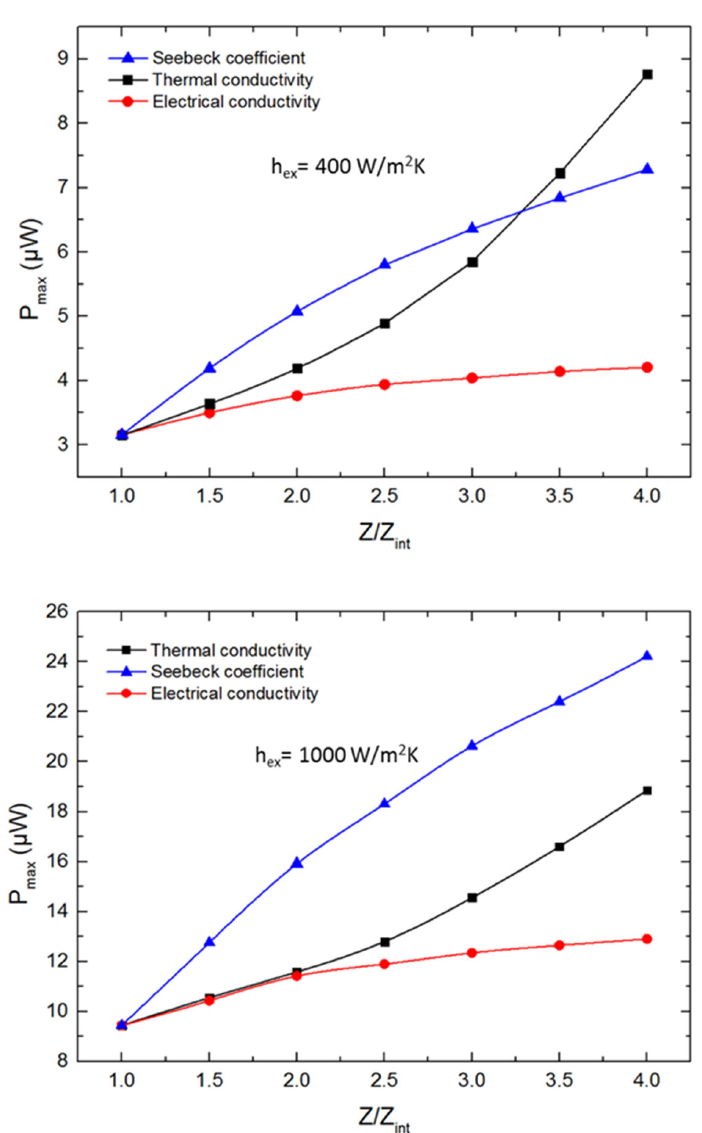
Figure 7. Maximum output power as a function of Z (cid:3027) calculations were performed with ρ c = 10 − 5 Ω cm 2 .